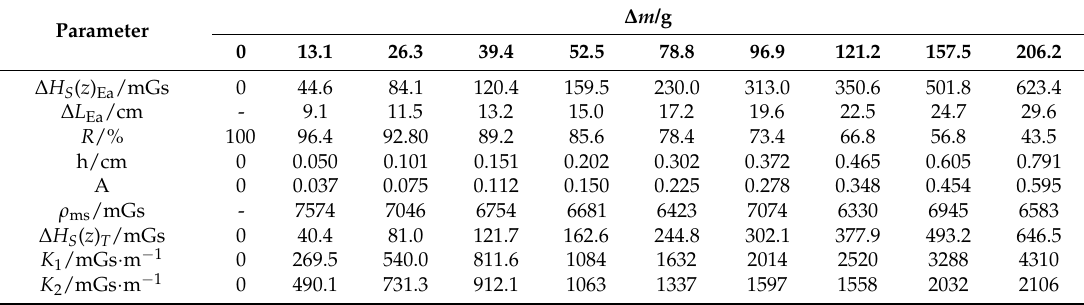
Table 3. The calculation parameters of gradient K .